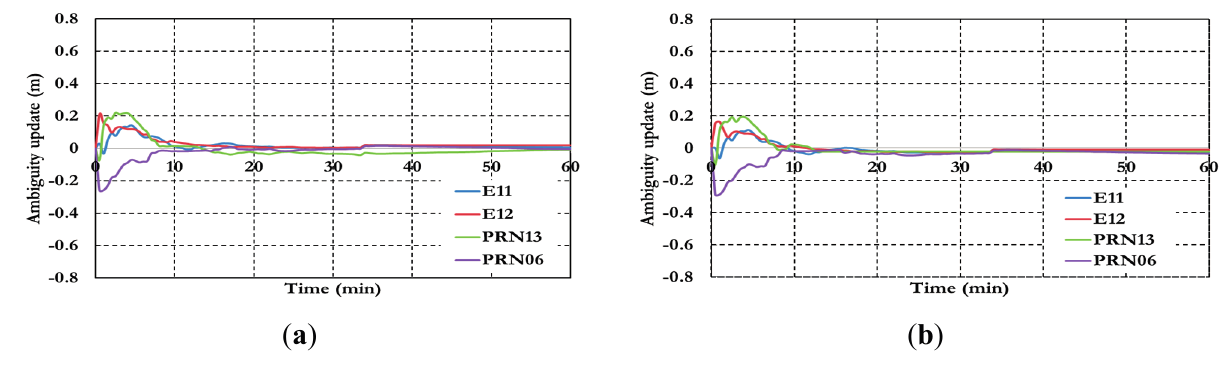
Figure 17. Ambiguity parameters the BSSD PPP tight combination model using ( a ) GPS reference satellite; and ( b ) Galileo reference